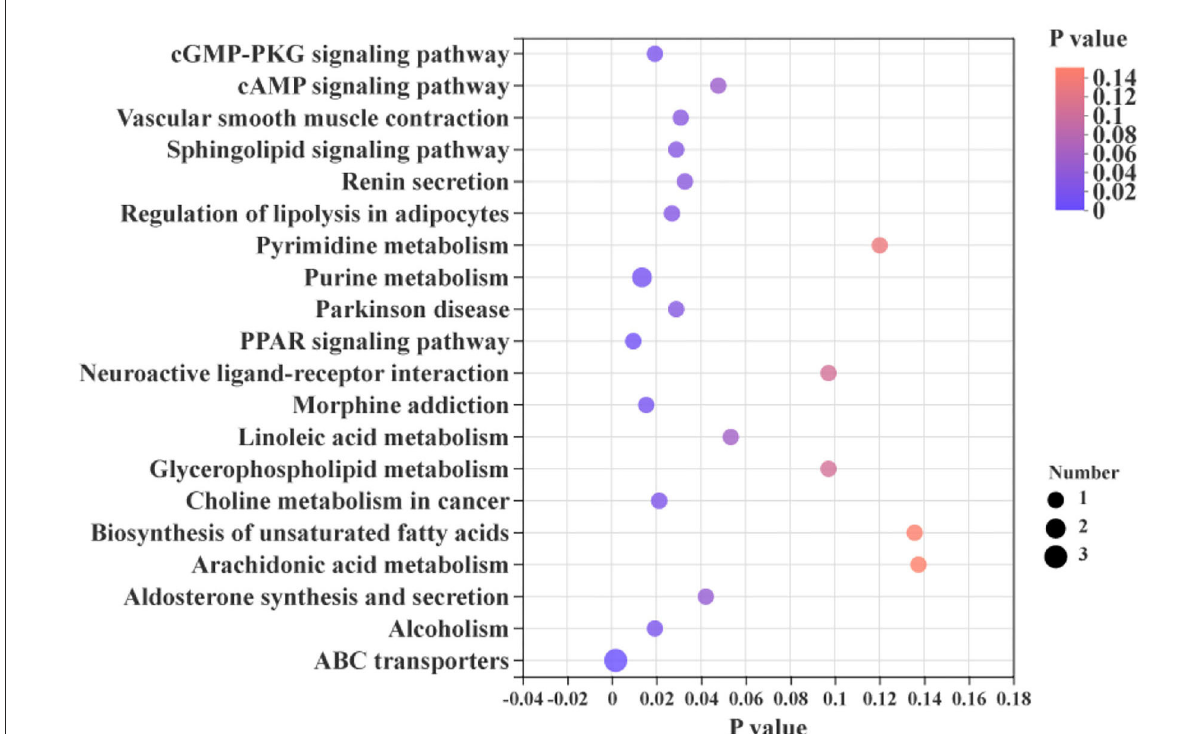
FIGURE7 KEGG enrichment analysis between the experimental group (VB3) and control group (Control).